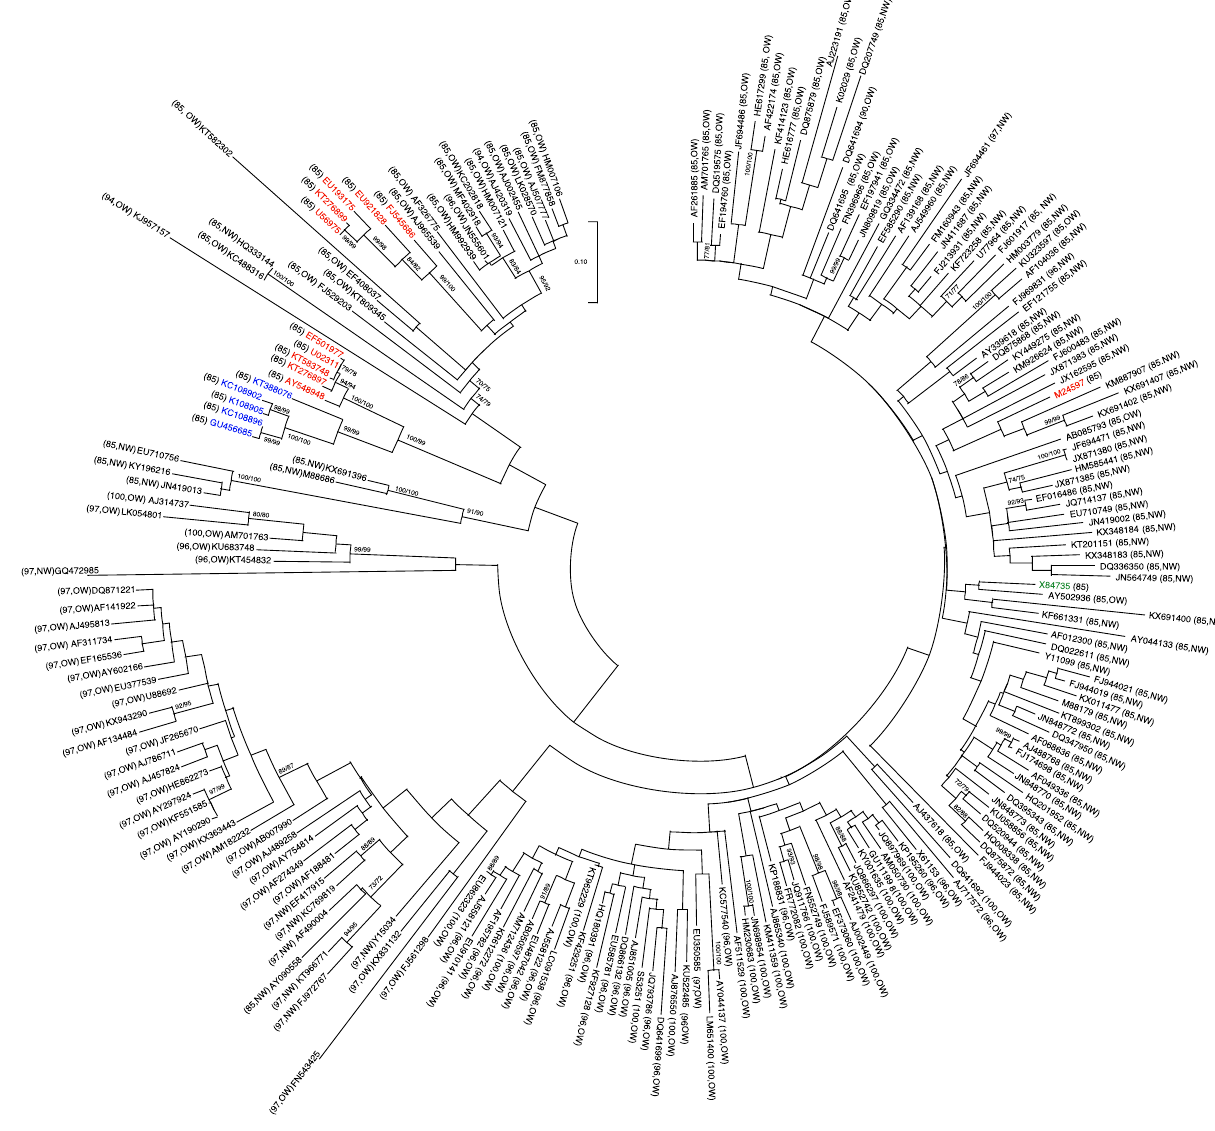
Figure 2. Maximum likelihood (ML) phylogenetic tree of C4(AC4) sequences of diverse geminivirus isolates. ML tree based on a Hasegawa, Kishino, and Yano model of evolution assuming a gamma distribution and invariable sites (HKY + G + I) showing genetic relationships among C4(AC4) sequences (nucleotides 1–255) from four genera of the family Geminiviridae ; exemplary isolates from 200 species of the Begomovirus genus, 11 isolates from the Beet curly top virus species of the Curtovirus genus, four isolates of the Turnip curly top virus species and the single isolate of the Turnip leaf roll virus species from the Turncurtovirus genus, and Tomato pseudo-curly top virus, the single isolate in the Topocuvirus genus. The ML tree for C1(AC1) sequences (255 nucleotides) that the C4(AC4) genes overlap is highly identical and not shown. Gene sequences are taken from full-length genomic sequences and the GenBank accession number of each virus is indicated. Preceding or following the GenBank accession numbers in parentheses are the amino acid length of the respective C4(AC4) proteins and the designation for New World (NW) or Old World (OW). Numbers at branches represent bootstrap values (≥ 70% are shown) determined from 500 replicates. Since the ML trees for C4(AC4) and C1(AC1) are nearly identical, bootstrap values for C4(AC4) and C1(AC1) are separated by a slash. The bar near the top of the cladogram represents nucleotide substitutions per site for the C4(AC4) sequences. Virus isolate(s) in black text are begomoviruses, red text are curtoviruses, blue text are turncurtoviruses, green text is a